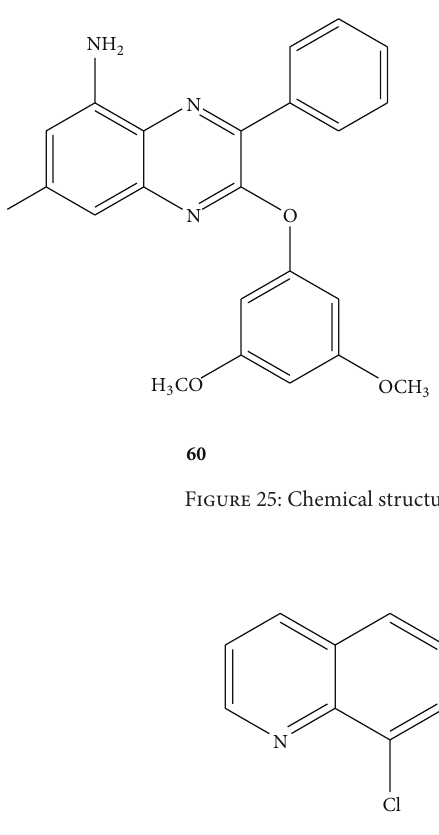
Figure 26: Chemical structure of compound 62